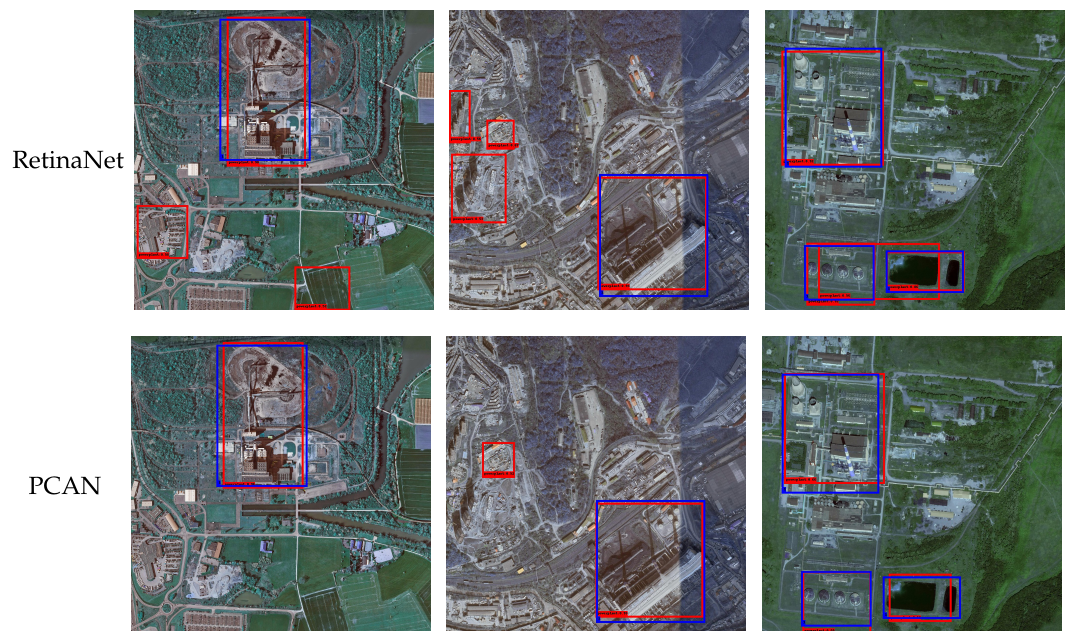
Figure 8. Detection results on Aerospace Information Research Institute-Thermal Power Plants Dataset for Detection (AIR-TPPDD) dataset. The blue box is the ground-truth, and the red box is the test result. Images at the top and the bottom are respectively the results of RetinaNet and our PCAN. The suppression of false alarms indicates that the proposed framework can generate effective deep features for thermal power